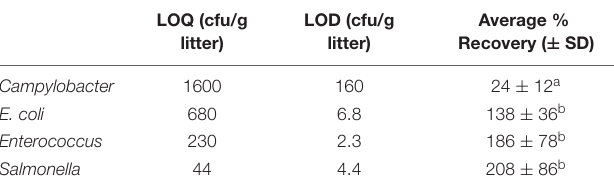
TABLE 1 | Limit of quantitation, detection, and percent recovery for this